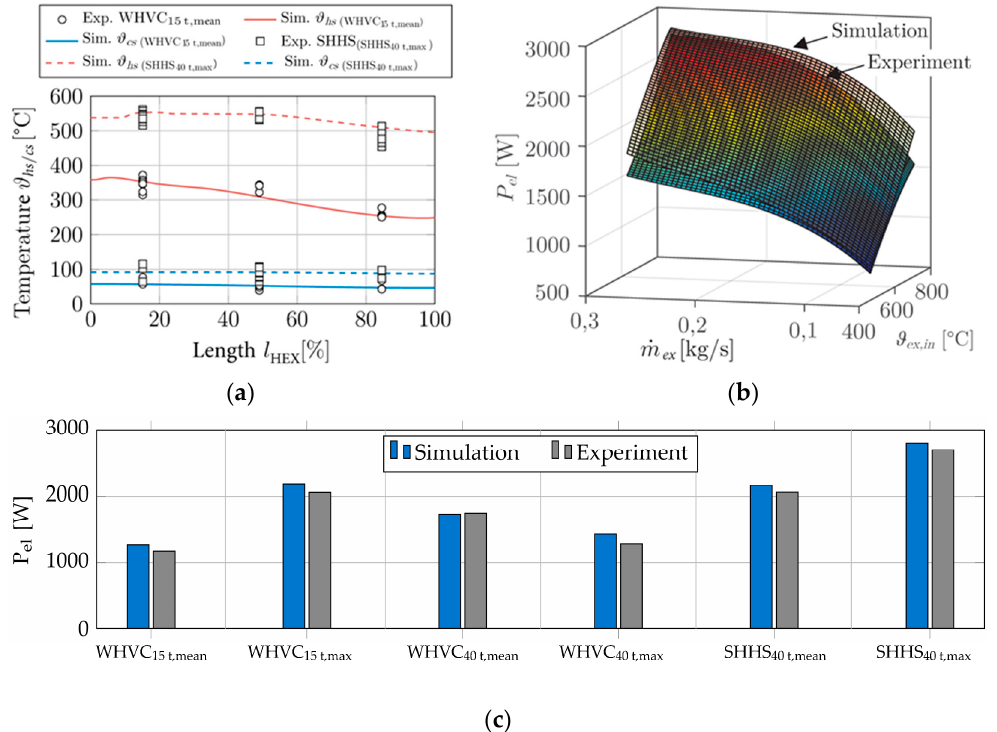
Figure 13. Results of the experimental investigation of the TEG functional model. ( a ) Module surface temperature. ( b ) Electrical output power map. ( c ) Exhaust gas back pressure at different operating points.